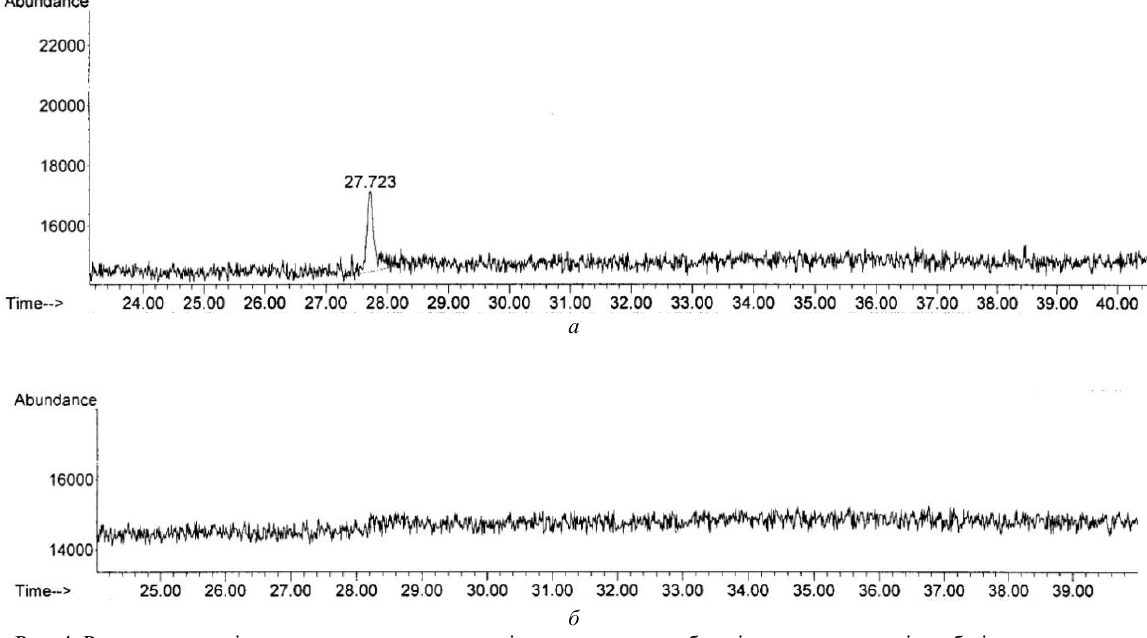
Рис. 4. Репрезентативні хроматограми сертиндолу, ізольованого з проб печінки: а – модельні проби із сертиндолом; б – контрольні проби